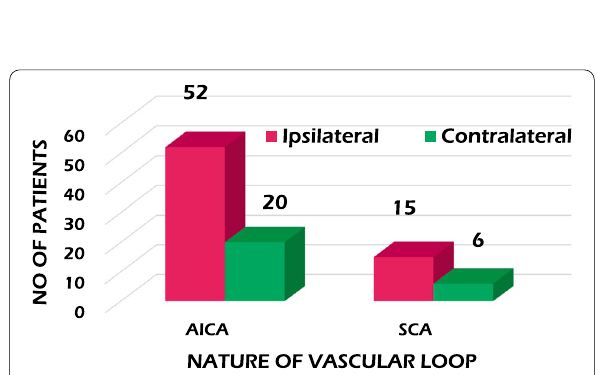
Fig. 6 Axial FIESTA showing vascular loop (thin arrow) at root entry zone of the left trigeminal nerve (thick